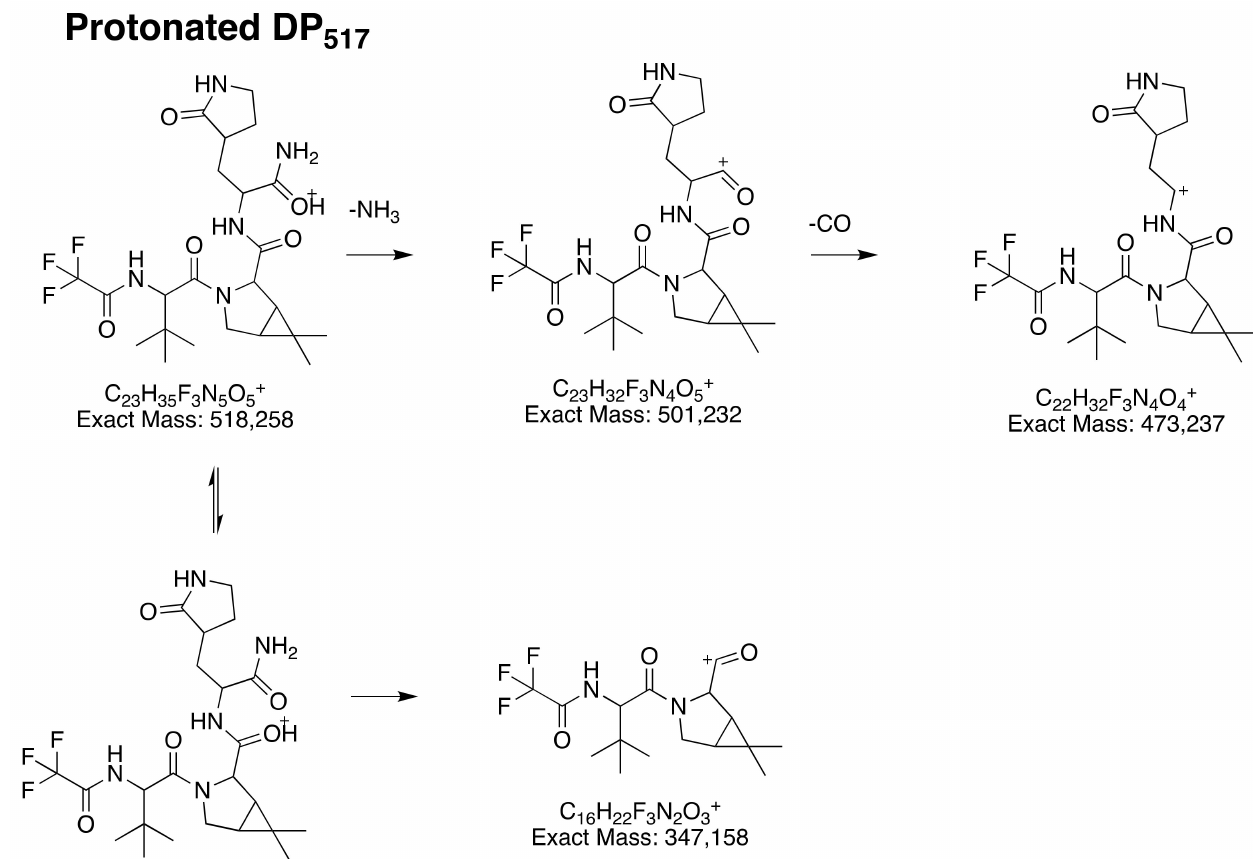
Figure 3. Proposed fragmentation pattern of protonated DP 517 ([DP 517 +H] +